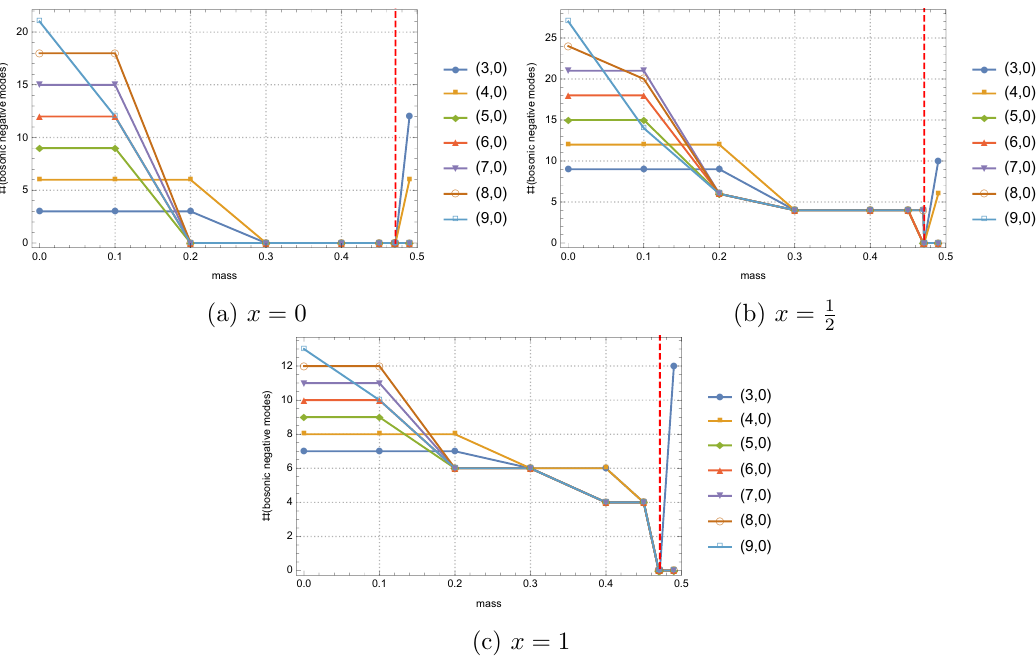
Figure 26. C [( N; 0)]+ D plus Higgs. For the con(cid:12)guration (B.9), the number of negative modes in the spectrum of O X for three representative x -values is shown in (a){(c) against a varying mass V; (cid:12)x parameter M . The red dashed vertical line indicates the critical mass value M (cid:3) . (cid:15) For x 2 (0 ; 1), the situation remains qualitatively the same. The properties remain independent of the brane size N